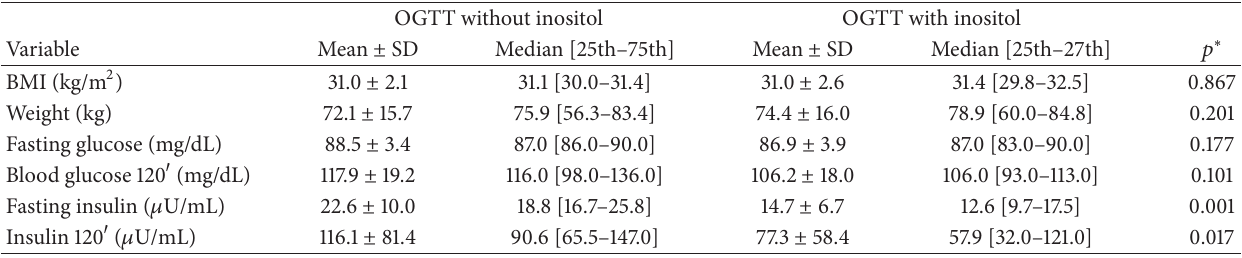
Table 3: Values at baseline (OGTT without inositol) and after 6 months (OGTT with inositol) of the subjects with a basal insulin level ≥ 15 𝜇